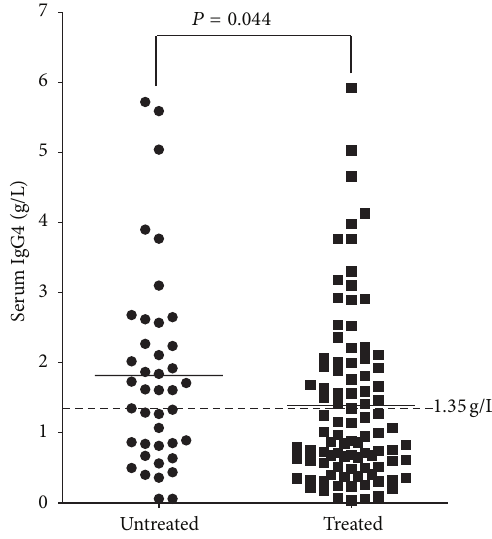
Figure 1: Comparison of serum IgG4 level between untreated and treated RA patients. Untreated RA patients ( 𝑛 = 41 ) had higher serum IgG4 level than that of treated RA patients ( 𝑛 = 95